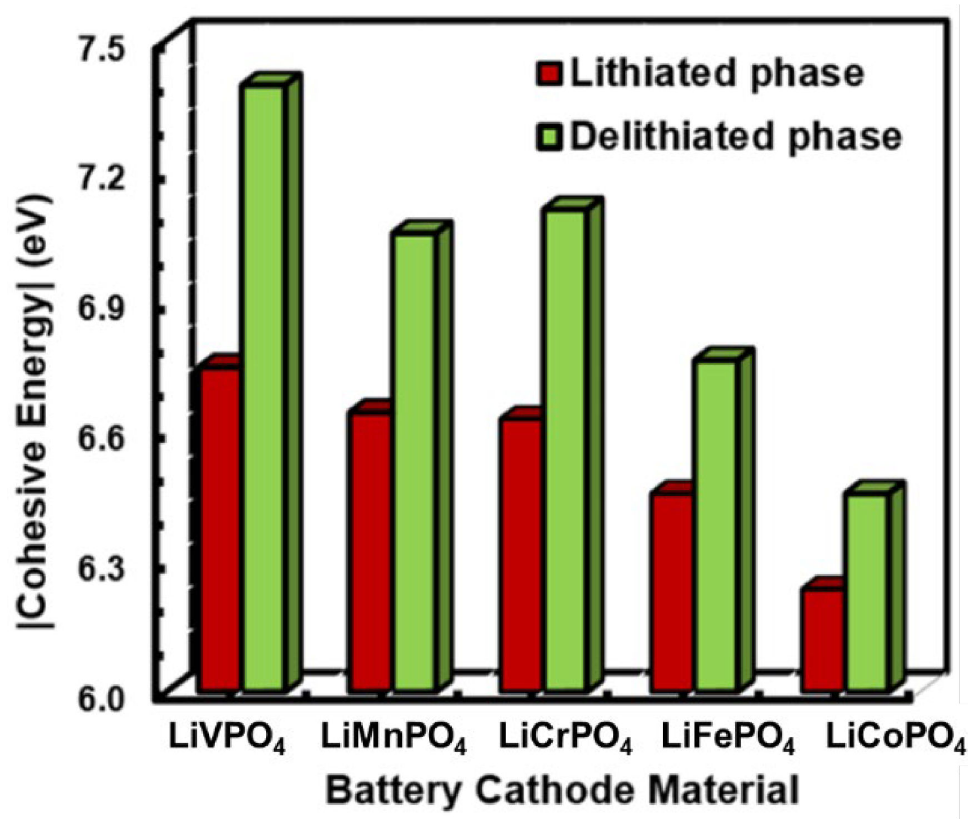
Figure 4. Comparative plots of cohesive energies in lithiated and de-lithiated phases for different LiMPO 4 cathode materials.